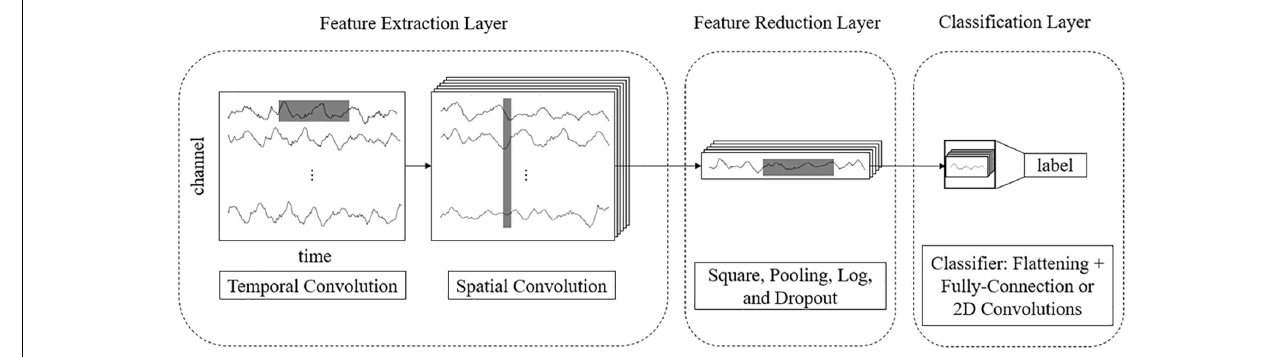
FIGURE 1 | Framework of the proposed MSFBCNN network.